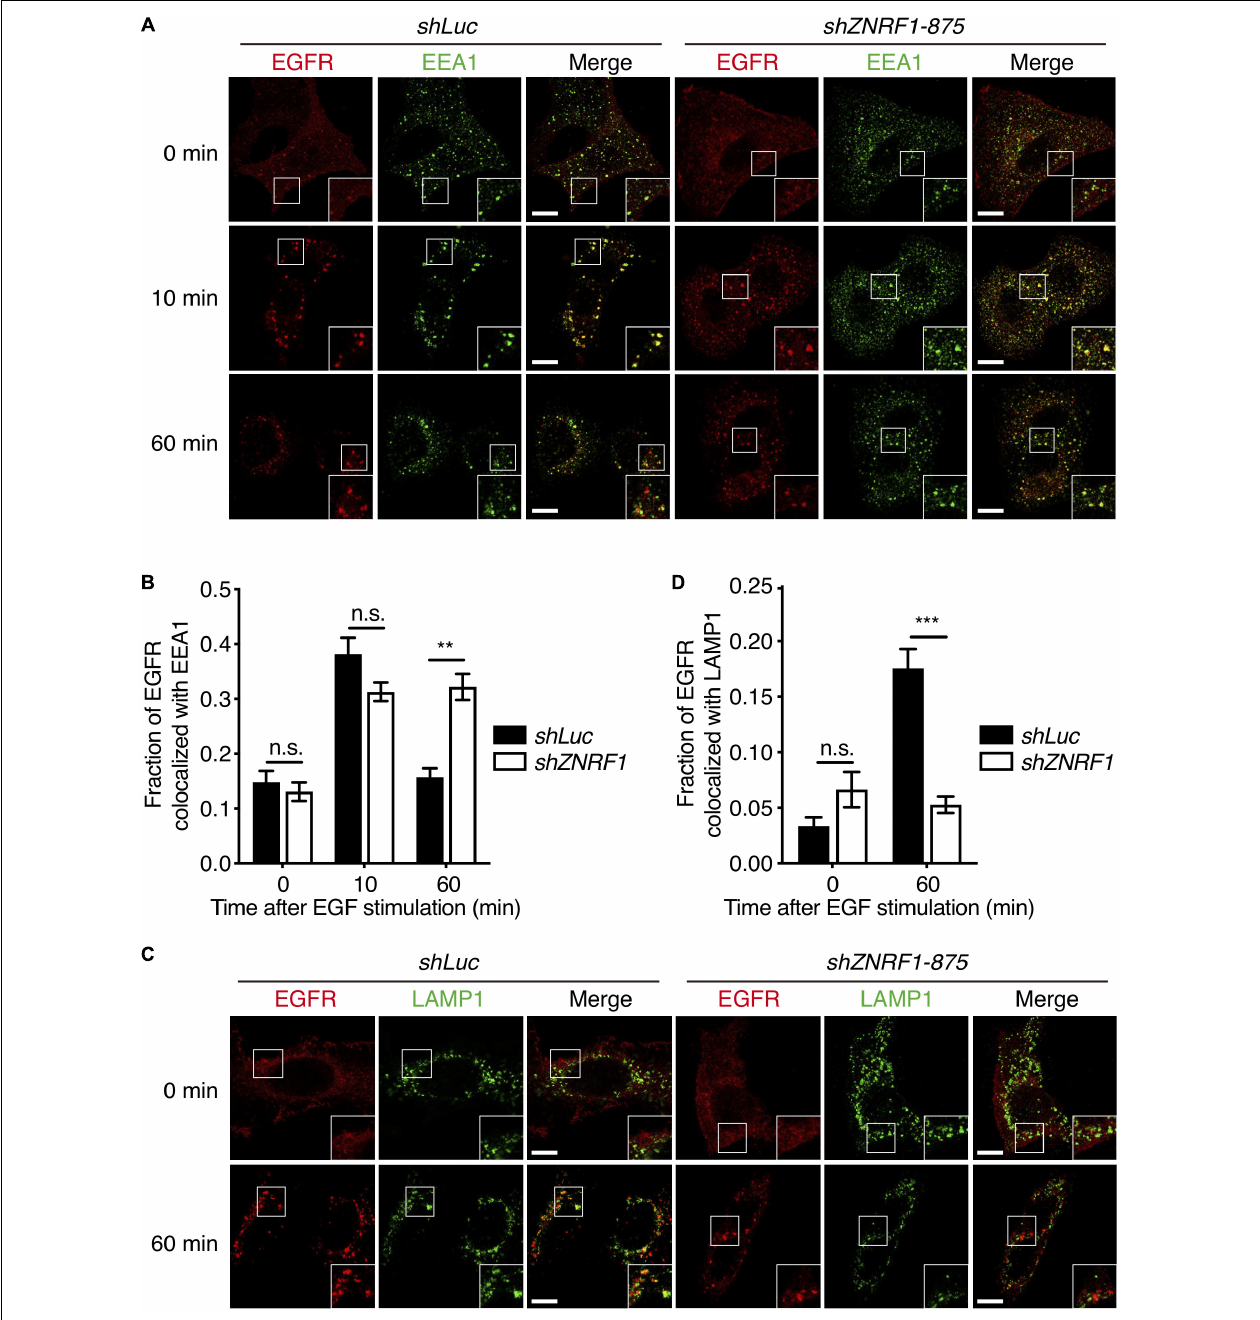
FIGURE 3 | ZNRF1 regulates EGFR trafficking. (A) A549 cells expressing shLuc or shZNRF1 shRNA were serum-starved overnight and then stimulated with 100 ng/mL EGF for the indicated times. Cells were co-stained with antibodies against EGFR (red) and EEA1 (green). (B) Quantification of the fraction of EGFR co-localized with EEA1 at the indicated times. (C) Control and shZNRF1 -expressing A549 cells pretreated with 100 µ M Chloroquine for 1 h and stimulated with 100 ng/mL EGF for 60 min. Cells were stained with antibodies against EGFR (red) and LAMP1 (green). (D) Quantification of the fraction of EGFR co-localized with LAMP1 in (C) . Data are presented as mean ± SEM, n > 500 puncta from 20 cells for each group. Scale bar, 10 µ m; n.s., no significant; ** P < 0.01, *** P < 0.001. All experiments were repeated two times with similar